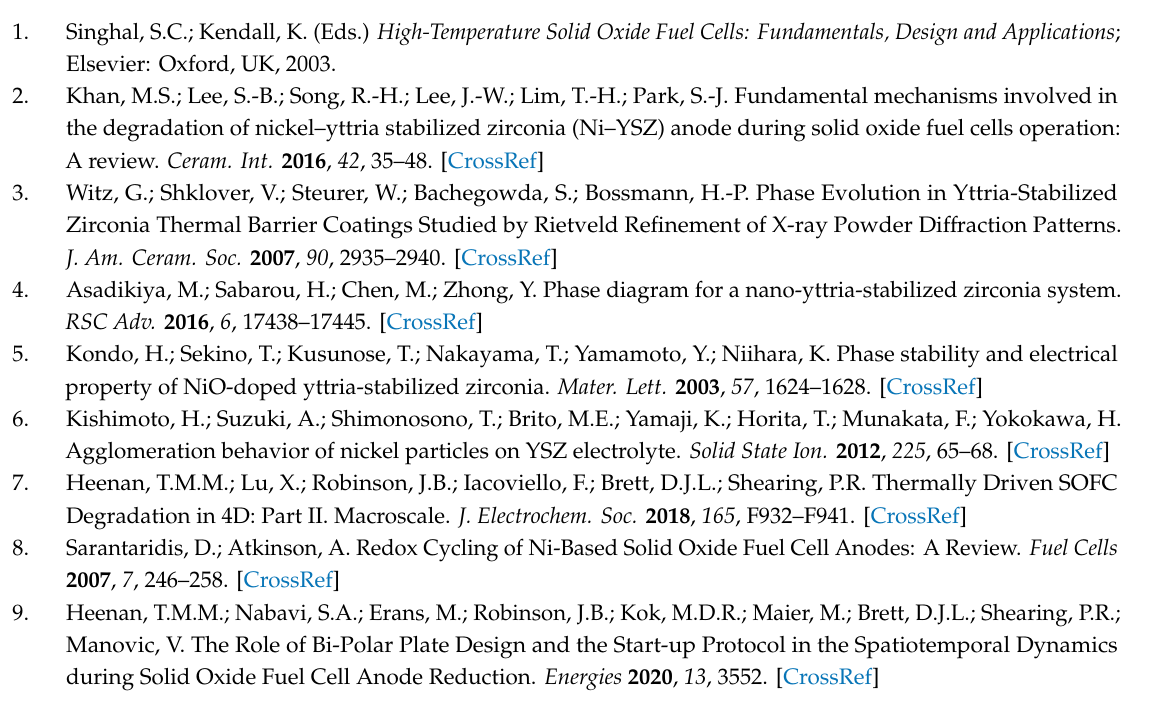
Figure S1: Full profile analysis using the Rietveld method for the mean di ff raction pattern extracted from the 3D-XRD-CT dataset, Figure S2: Simulated di ff raction patterns for NiO, YSZ, ZrO2 and Ni, Figure S3: Composition by weight calculated from XRD, Figure S4: Correlation of transmission X-ray microscopy (TXM) and di ff raction computed tomography